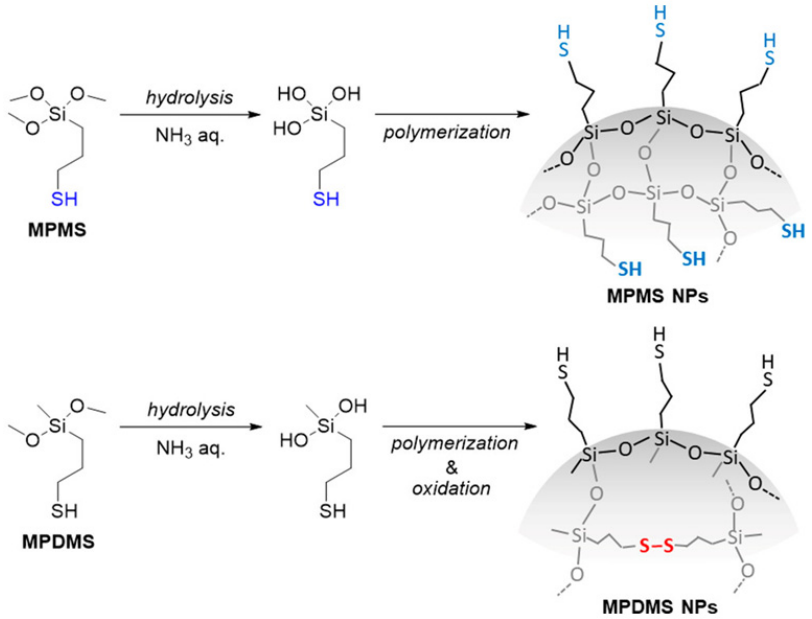
Figure 12. Structures of organosilica nanoparticles (ONPs) derived from (3-mercaptopropyl)tri- methoxysilane (MPMS) and (3-mercaptopropyl)methyldimethoxysilane (MPDMS) precursors. (MPMS) and (3-mercaptopropyl)methyldimethoxysilane (MPDMS) precursors. Reprinted with permission from [81]. Copyright (2018) American Chemical Reprinted with permission from [81]. Copyright (2018) American Chemical Society.